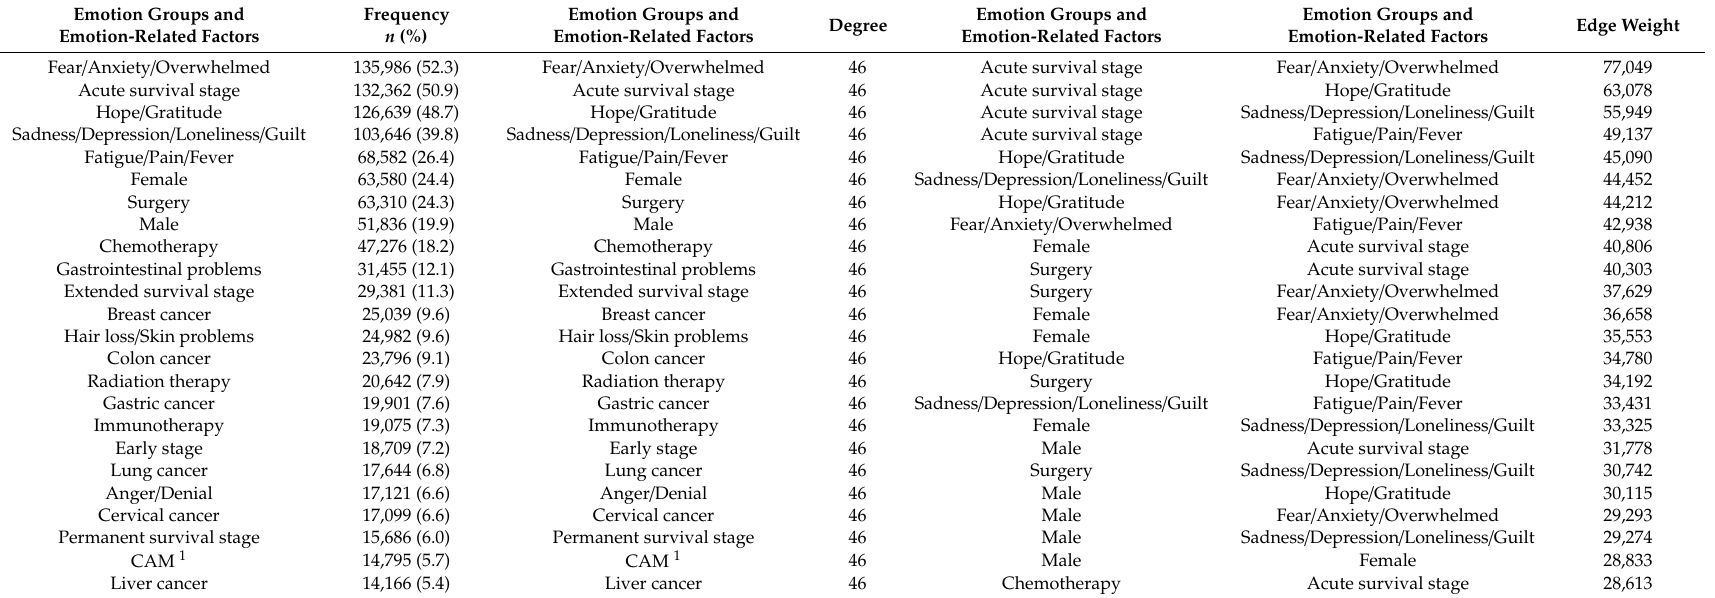
Table 3. Top 24 nodes with degree and edge weight on internet blogs, online caf é s, and message